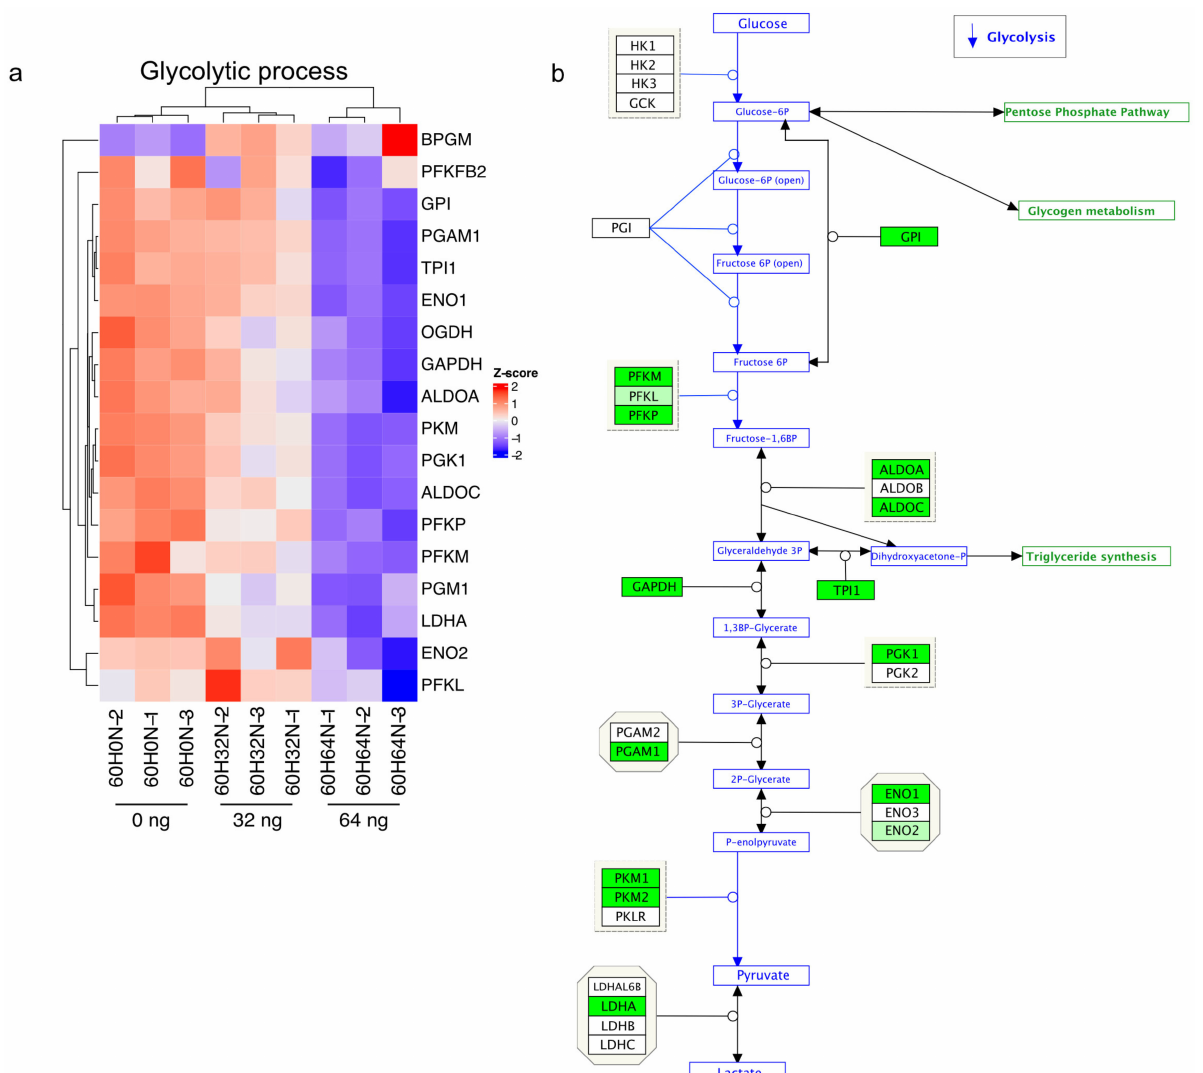
Figure 4. Effect of everolimus treatment on glycolysis. ( a ) Heatmap illustrating RNA-Seq differential expression for genes associated with glycolytic process (GO:0006096, padj < 0.5). ( b ) Schematic representation of the glycolysis pathway with the genes that are significantly overexpressed in everolimus-treated cells compared with untreated tissue after 60 h indicated in green (and slightly upregulated in light